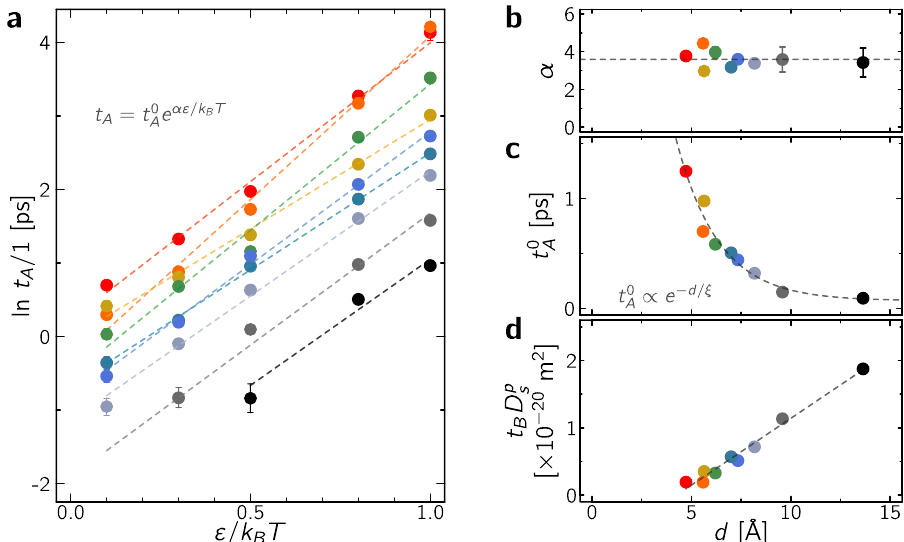
Fig. 4 Residence and relocation times. a Logarithm of the residence time t A as a function of ε / k B T where t A is obtained by mapping the molecular and mesoscopic tortuosities as shown in Fig. 3c. The dashed lines are fi ts in the form t A ¼ t 0 A exp ð αε = k B T Þ with t 0 A the characteristic residence time for vanishing fl uid/surface interactions. The error bars are those given in Fig. 3c. b Impact of pore size d on the dimensionless parameter α ; α = 3.6 ± 0.4 ∀ p . The error bars correspond to fi tting errors. c Characteristic residence time t 0 A as a function of mean pore size d . The dashed line is a fi t against an effective decaying (cid:3) (cid:4)(cid:7) (cid:8) function t 0 A / t 0 A ; 1 1 þ γ exp (cid:2) d = ξ with the critical pore size ξ = 2.1 ± 0.5 Å and t 0 A ; 1 (cid:3) 0 : 07 ps. d Relocation time t B ´ D p s as a function of the mean pore size d for ε / k B T = 1. As expected, t B / d = D p s as the fi nite time spent upon relocation in the cavities introduces an upper bound in the survival probability (see